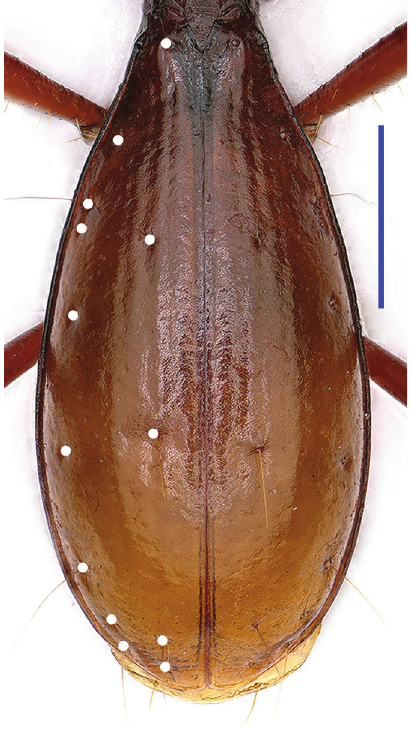
Figure 4. Elytra of Shuangheaphaenops elegans gen. n., sp. n., holotype, male, chaetotaxal pattern shown by white points. Scale bar 1 mm.